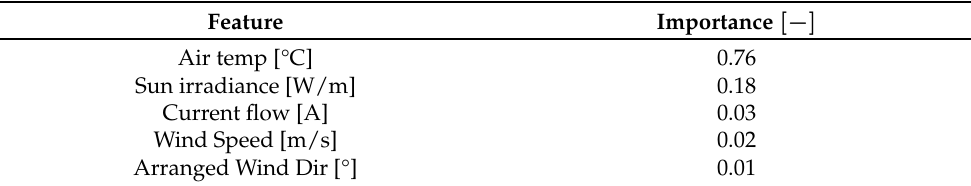
Table 1. This table collects values representing the features importance, computed employing the Random Forest Regressor built-in feature importance metric, as the normalized total reduction in the Gini impurity brought by that feature. The table clearly shows the predominant importance of the air temperature followed by the sun irradiance. Together, they account for more than 90% of the relevant information in predicting the conductor